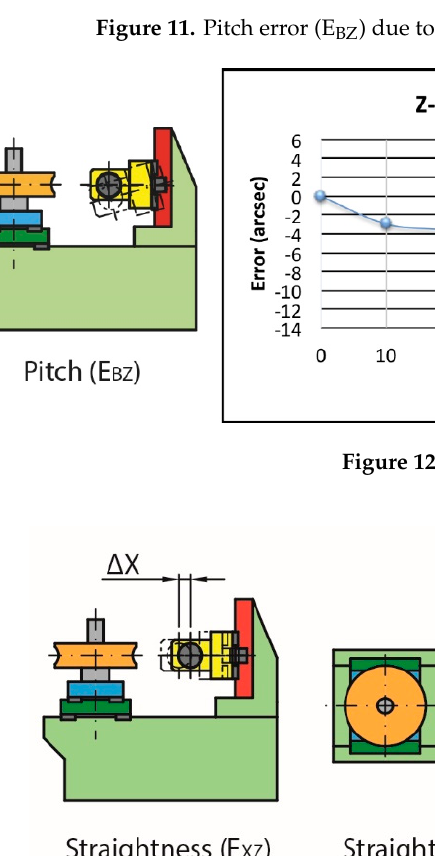
Figure 13. Non-compensated errors (X-axis) due to movement along